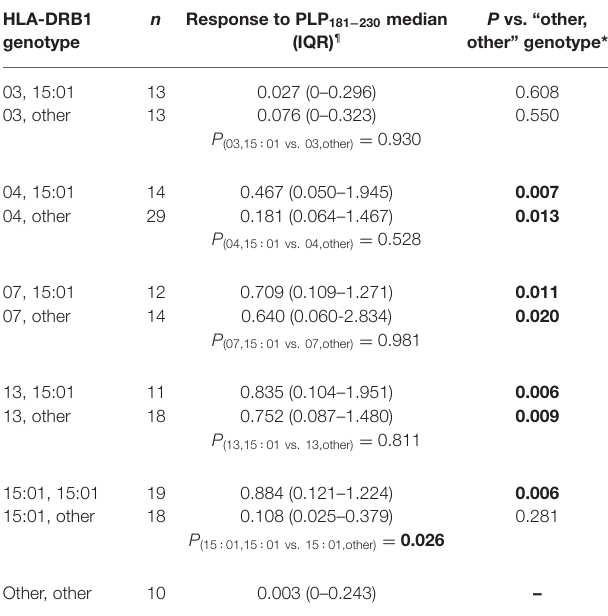
IgG subtype (83.9%) was highly significantly different from that of healthy controls (11.1%; P = 1.8 × 10 − 9 ) and that of OND patients (18.8%; P = 2.0 × 10 − 7 ) by χ 2 with Yates’ correction.